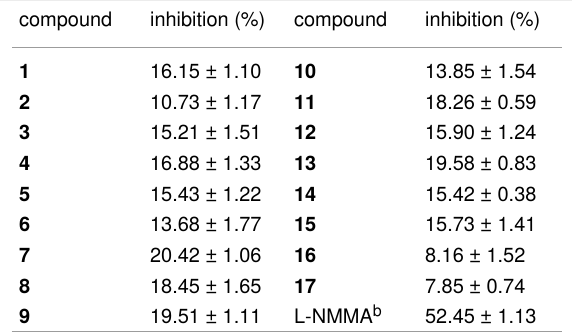
Table 2: Inhibitory activities of compounds 1 − 17 on LPS-stimulated NO production. a